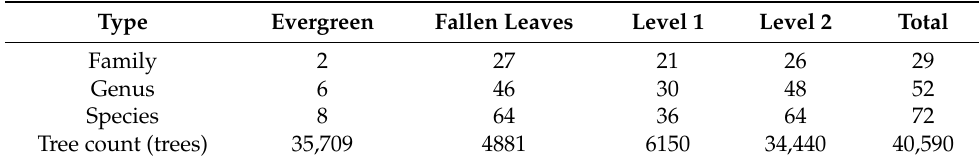
Table 3. Statistical table of large old tree resources in Beijing.